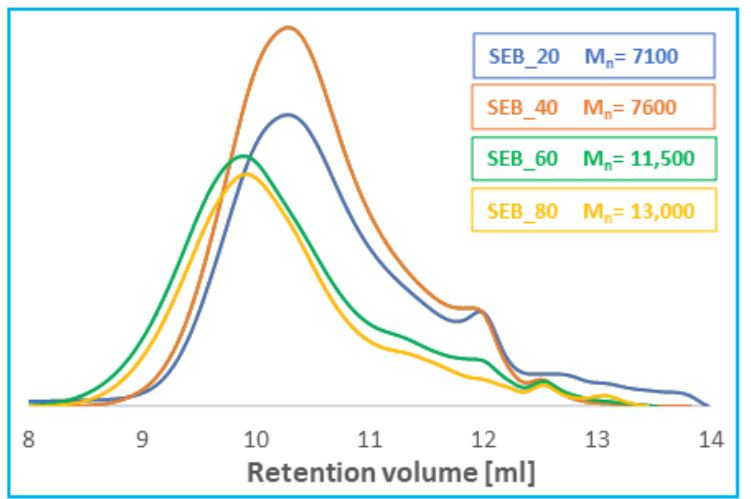
Figure 3. Gel-permeation chromatography (GPC) chromatograms of DBB-SEB polyanhydrides. The thermal properties of the copolymers, such as glass transition temperature (Tg), melting temperature (Tm) and heat of fusion of melting process ( ∆ Hm), were investigated using the DSC method (Table